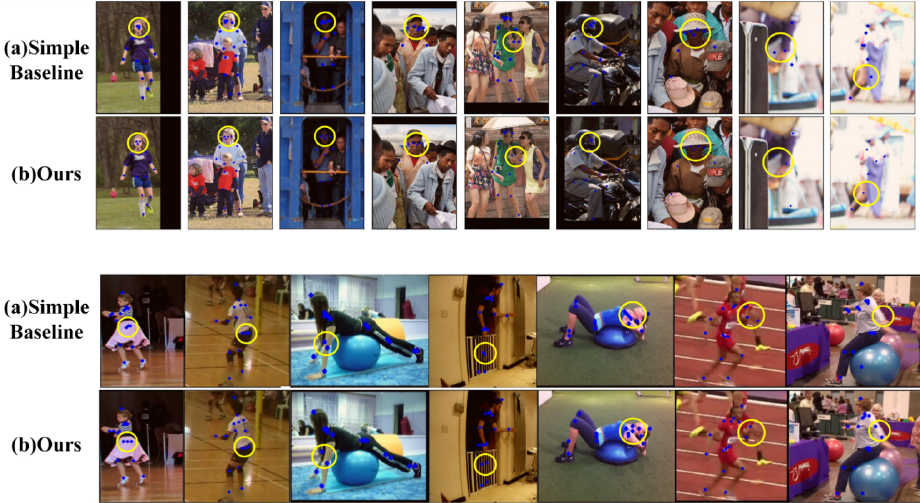
Figure 6. Visual comparison results of different models. The COCO dataset results are at the top, and the MPII dataset results are at the bottom. ( a ) Simple Baseline has poor recognition results under dense key points, blurred images, and occlusion. ( b ) Our approach mitigates these problems by incorporating pixel-coordinate position information.